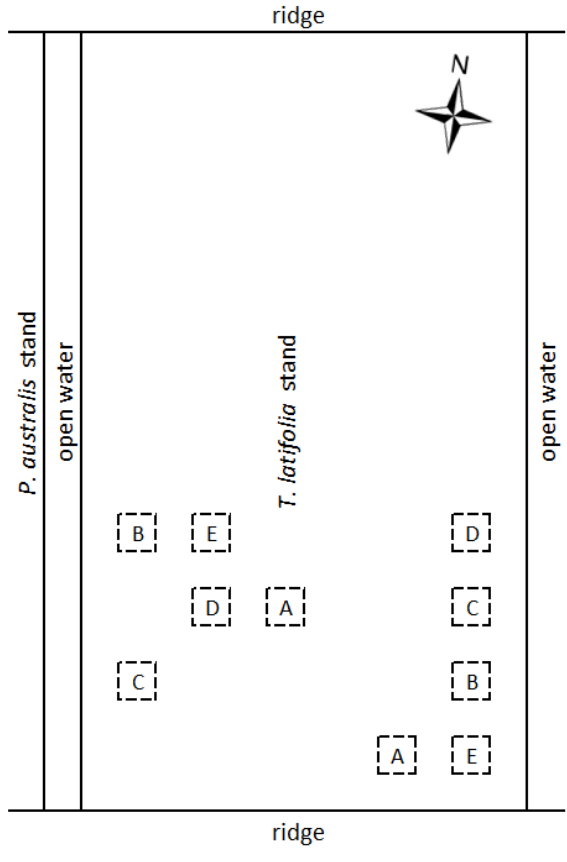
Figure 1. Experiment I. Schematic overview of the experimental field (6 × 10 m) used for harvesting T. latifolia biomass. The field was surrounded by soil ridges at north and south sides and by open water (≥ 0.75 m) at west and east sides. Harvested plot surfaces were 0.25 m 2 , and harvest dates were 31 May (A), 07 July (B), 0 3 August (C), 15 September (D) and 28 October 2016 (E)